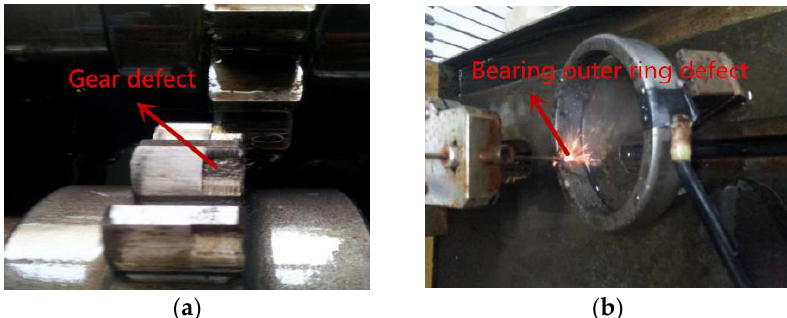
Figure 10. Figure of gear and bearing outer ring fault. ( a ) Gear pitting failure; and ( b ) Implantation of outer ring fault by EDM.